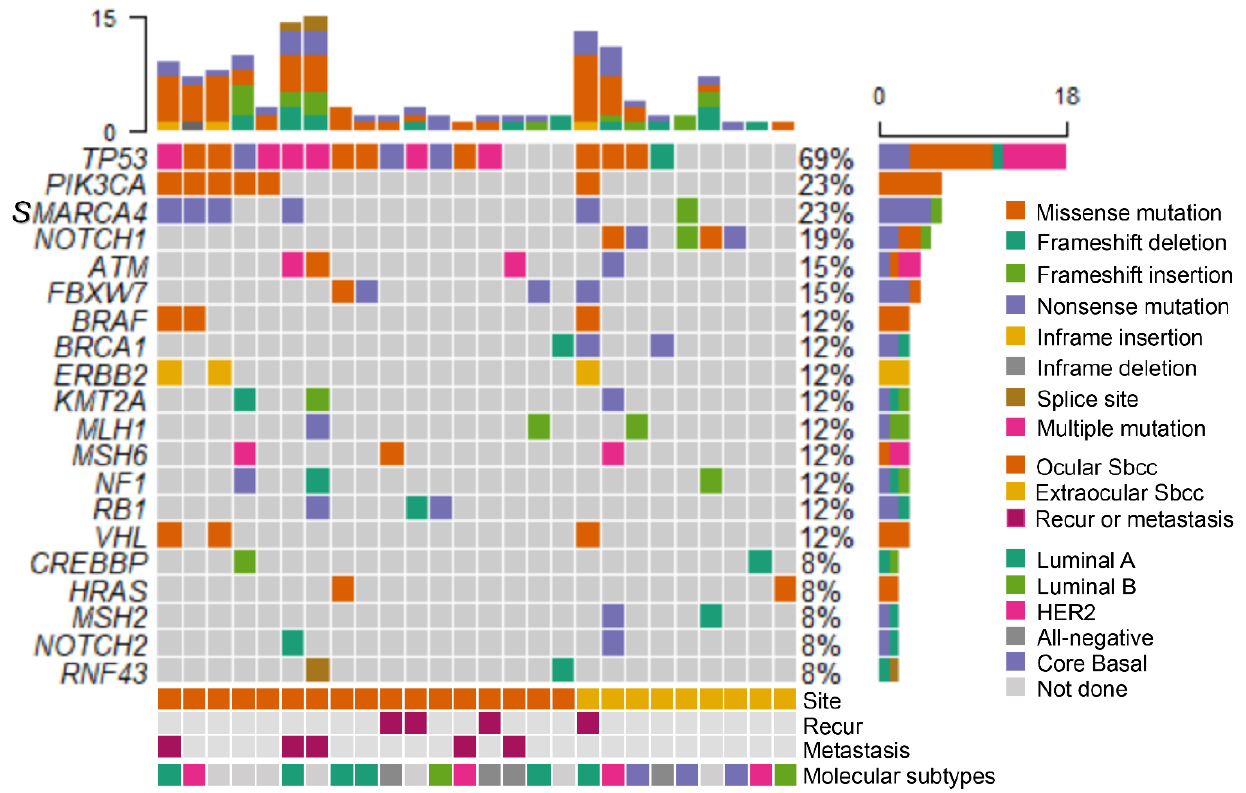
Figure 1. Oncoplot of ocular and extraocular sebaceous carcinomas. TP53 and PIK3CA genes were frequently mutated in ocular sebaceous carcinomas, while the NOTCH1 gene was more commonly mutated in extraocular sebaceous carcinomas.